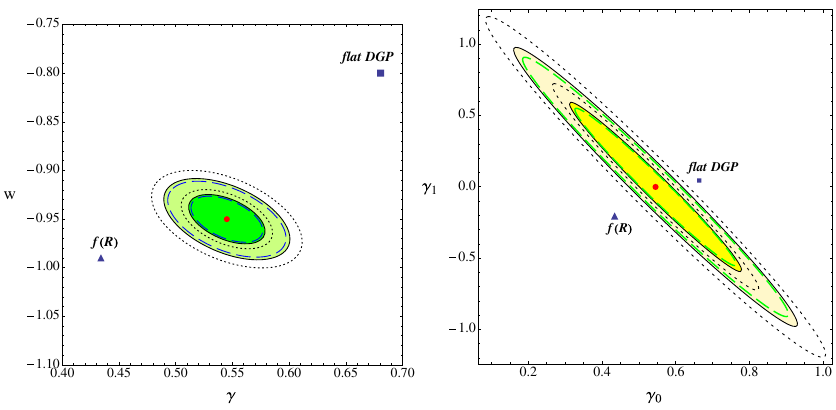
Fig. 20 γ -parameterization. Left panel: 1 and 2 σ marginalized probability regions for constant γ and w : the green (shaded) regions are relative to the Reference case , the blue long-dashed ellipses to the Optimistic case , while the black short-dashed ellipses are the probability regions for the Pessimistic case . The red dot marks the fiducial model; two alternative models are also indicated for comparison. Right panel: 1 and 2 σ marginalized probability regions for the parameters γ 0 and γ 1 , relative to the Reference case (shaded yellow regions), to the Optimistic case (green long-dashed ellipses), and to the Pessimistic case (black dotted ellipses). Red dots represent the fiducial model, blue squares mark the DGP while triangles stand for the f ( R ) model. Then, in the case of γ -parameterization, one could distinguish these three models (at 95% probability) Table 5 Numerical values for 1 σ constraints on parameters in Fig. 20 and figures of